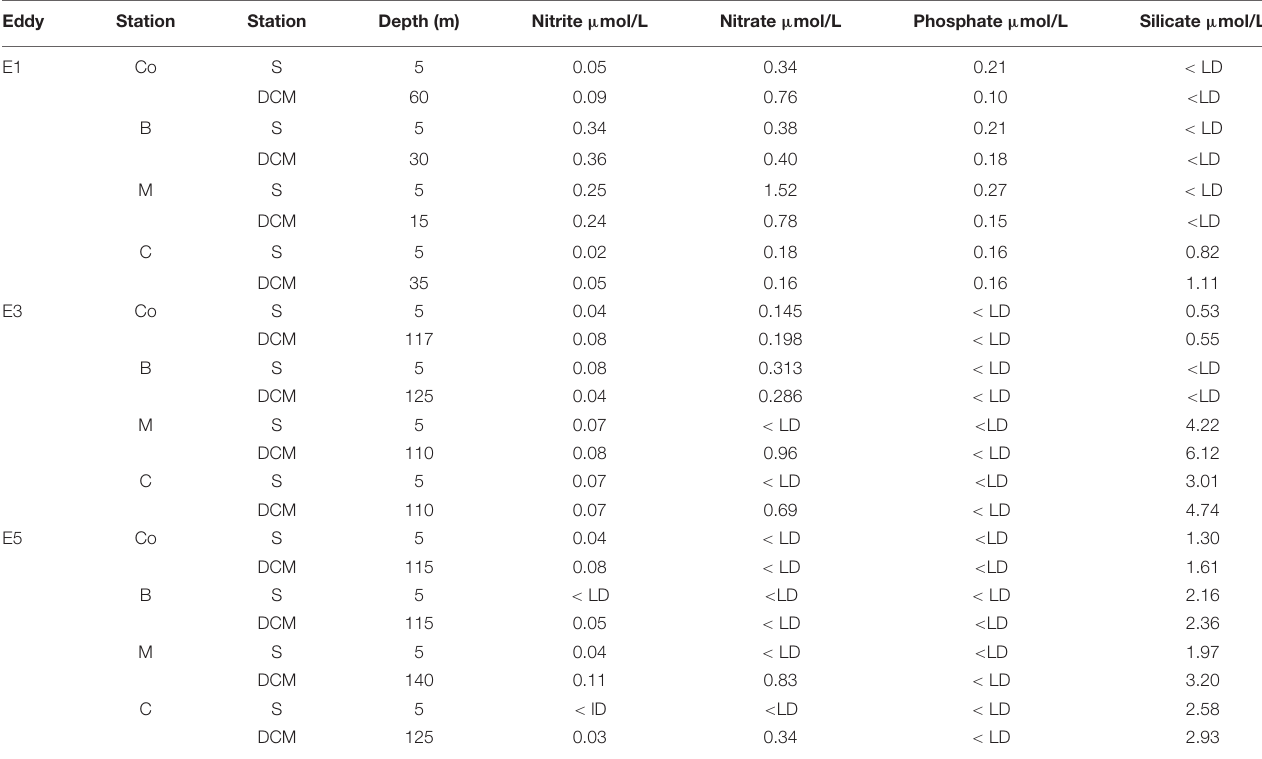
TABLE 2 | Nutrients data (nitrite, nitrate phosphate, and silicate— µ mol/L) from the eddies 1, 3, and 5, in different stations (Co, B, M, and C) and depths (S, subsurface; and DCM, the depth of chlorophyll maximum). Eddy Station Station Depth (m) Nitrite µ mol/L Nitrate µ mol/L Phosphate µ mol/L Silicate µ mol/L